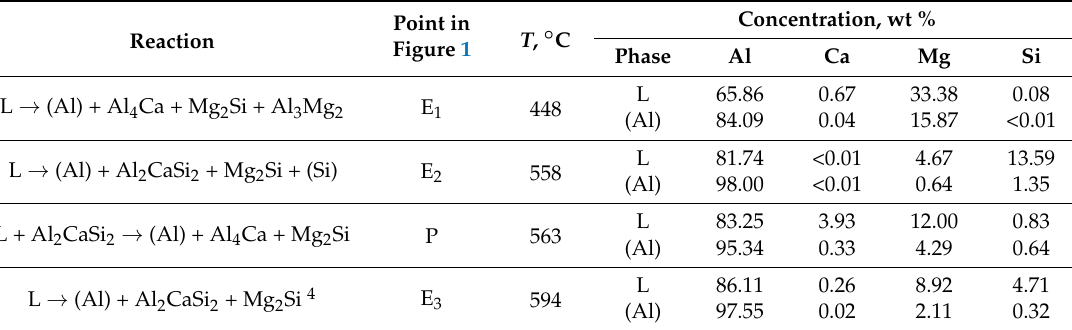
Table 3. Calculated parameters of invariant reactions in the Al-Ca-Mg-Si system.